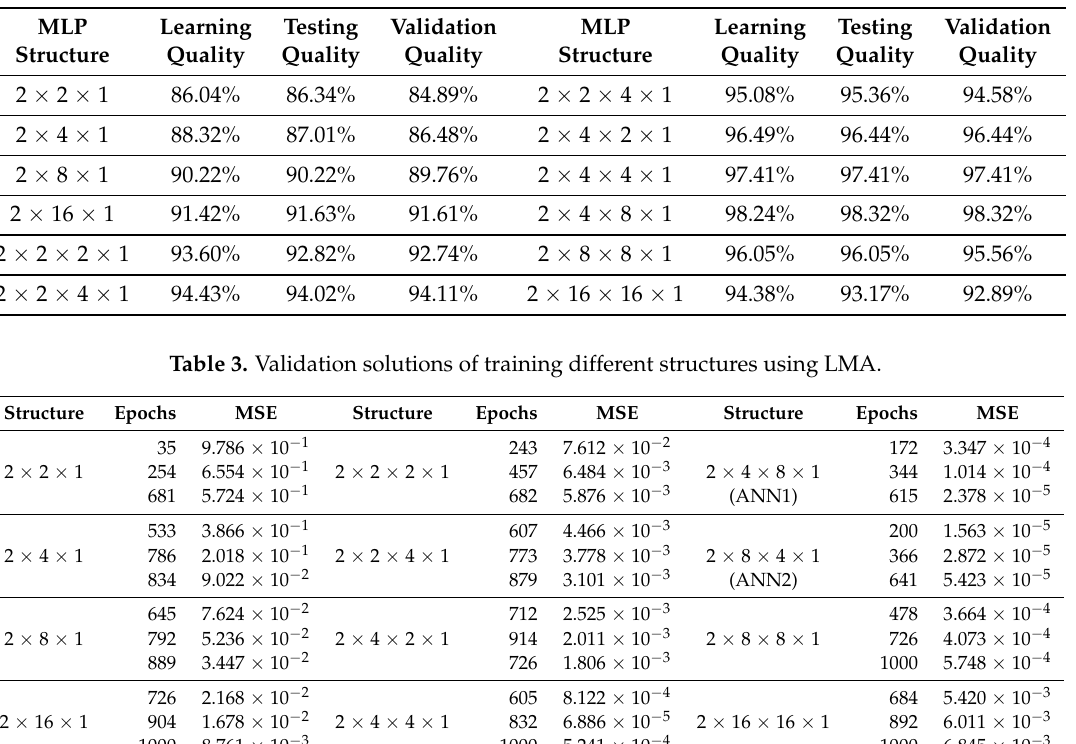
Table 2. Calculation results of different MLPs using LMA.